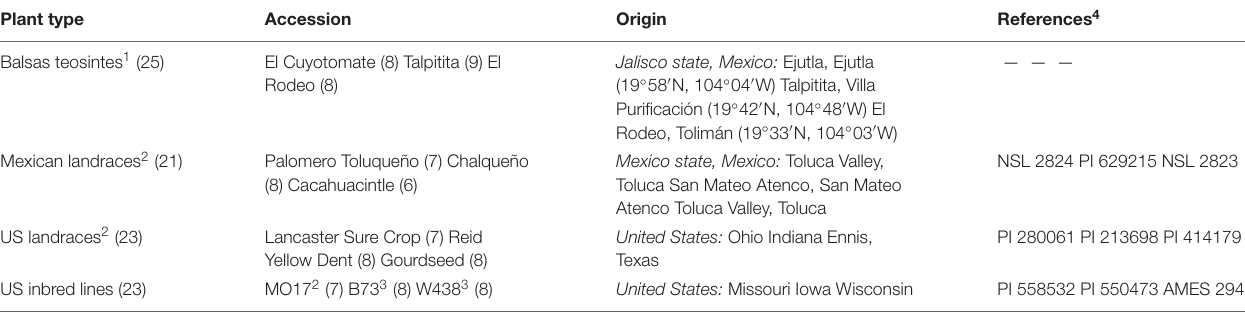
TABLE 2 | Plant types, accessions and number of bio-replicates per each (in parenthesis), and their geographic origins and reference numbers. Plant